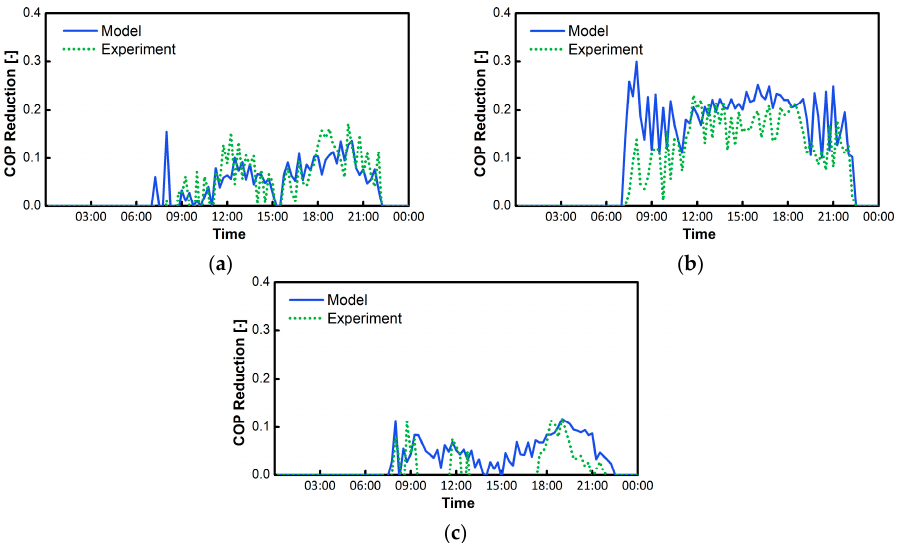
Figure 11. Reduction of COP in faulted scenarios: nonstandard refrigerant charging. ( a ) 15% undercharge; ( b ) 30% undercharge; ( c ) 15% overcharge.